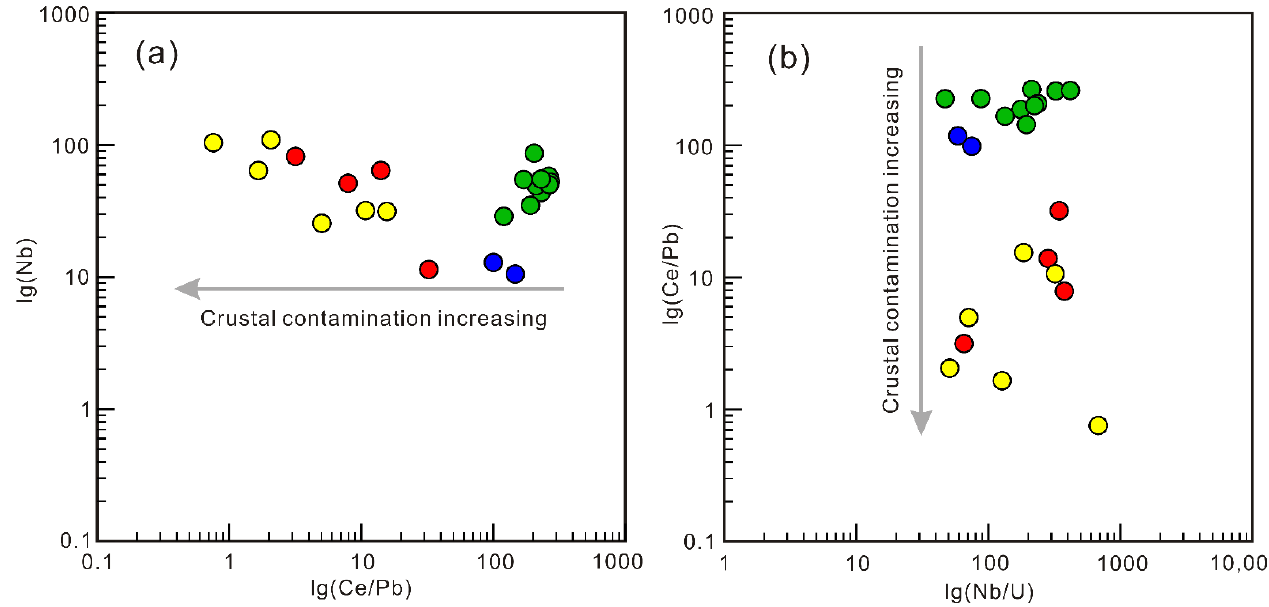
Figure 13. Plots of lg(Nb) vs. lg(Ce/Pb) ( a ) and lg(Ce/Pb) vs. lg(Nb/U) ( b ) of amphiboles from the Huangyangshan deposit. Symbols are as in Figure 4.